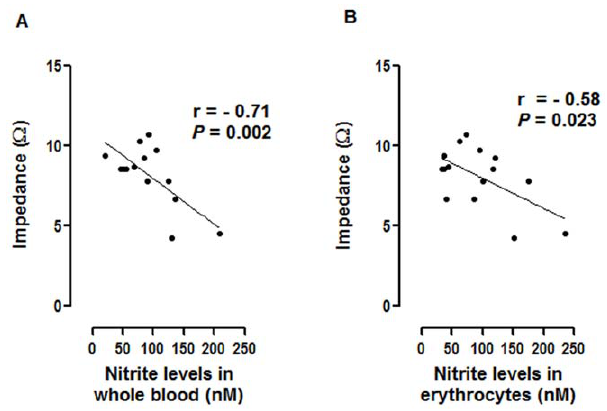
Figure 6. Platelet aggregation in whole blood showed inverse correlation with the nitrite levels in whole blood and erythrocytes. Platelet aggregation in whole blood (20% hematocrit) was induced by 10 m M ADP and monitored for 5 min using the impedance aggregometry. The degree of platelet aggregation was correlated with the nitrite levels in whole blood (A) and erythrocytes (B). Each dot represents mean of duplicate measurement (n=15).